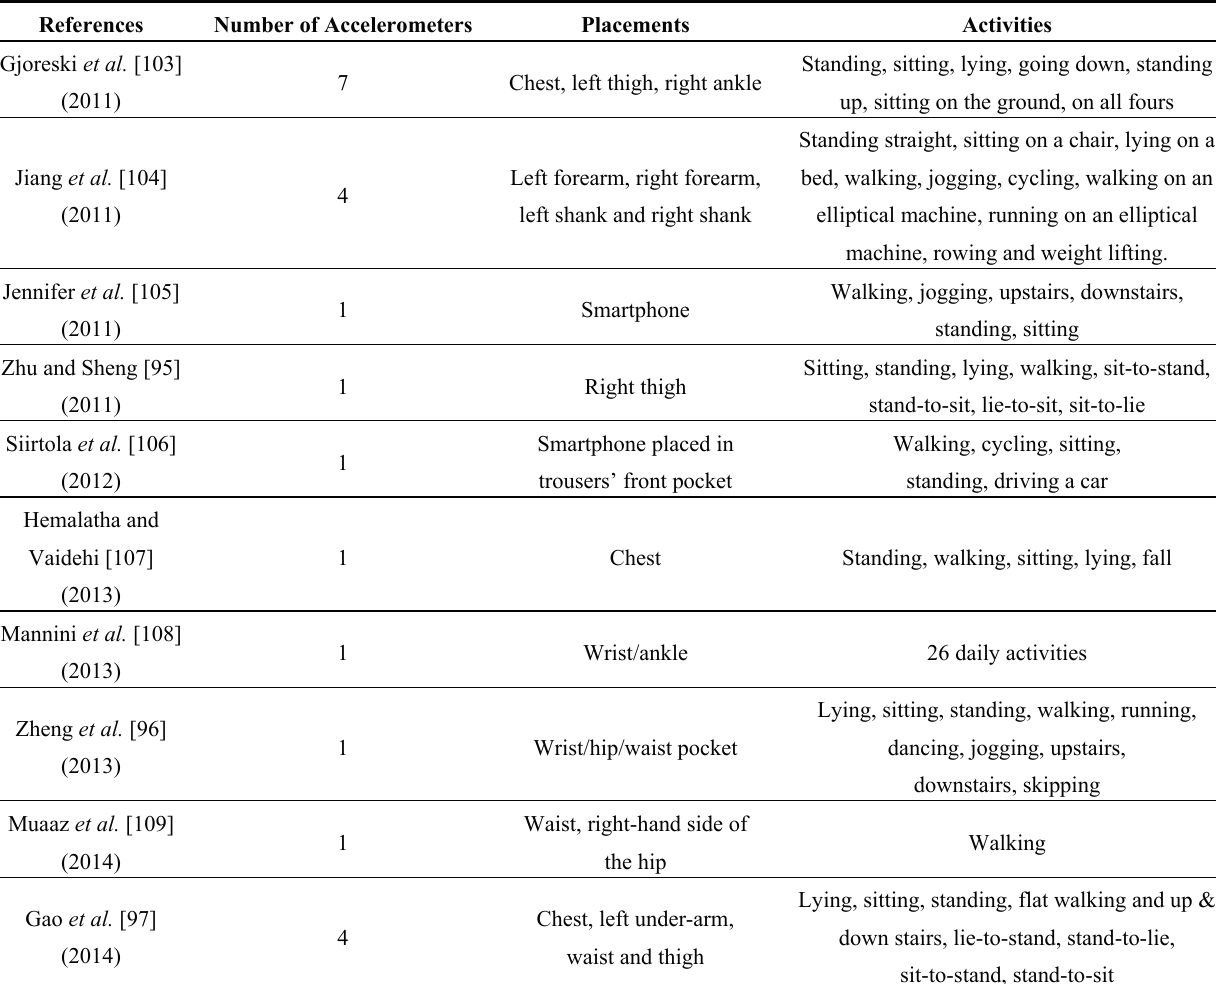
Table 5. Different placements of accelerometers on human body for activity